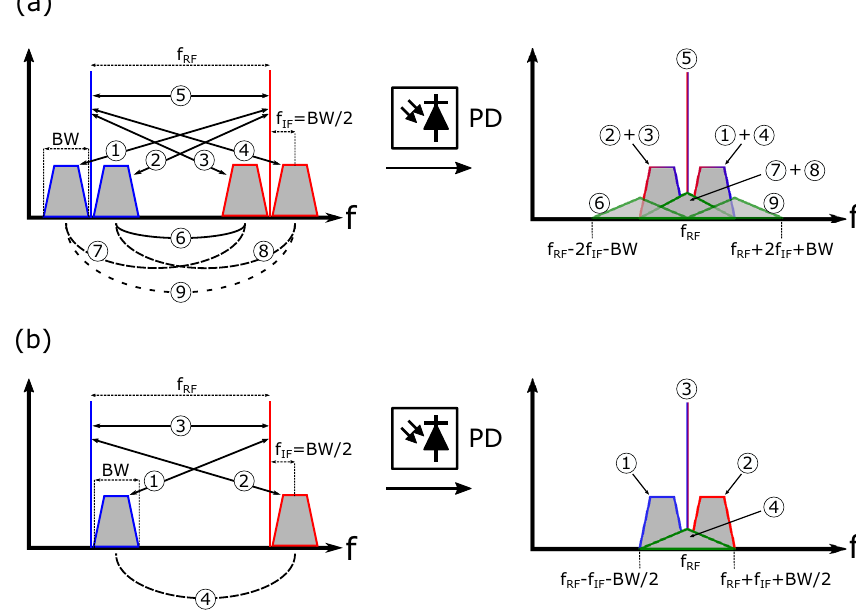
Figure 2. RF beatings generated with ( a ) DSB-C optical modulation, and ( b ) with SSB-C optical modulation.